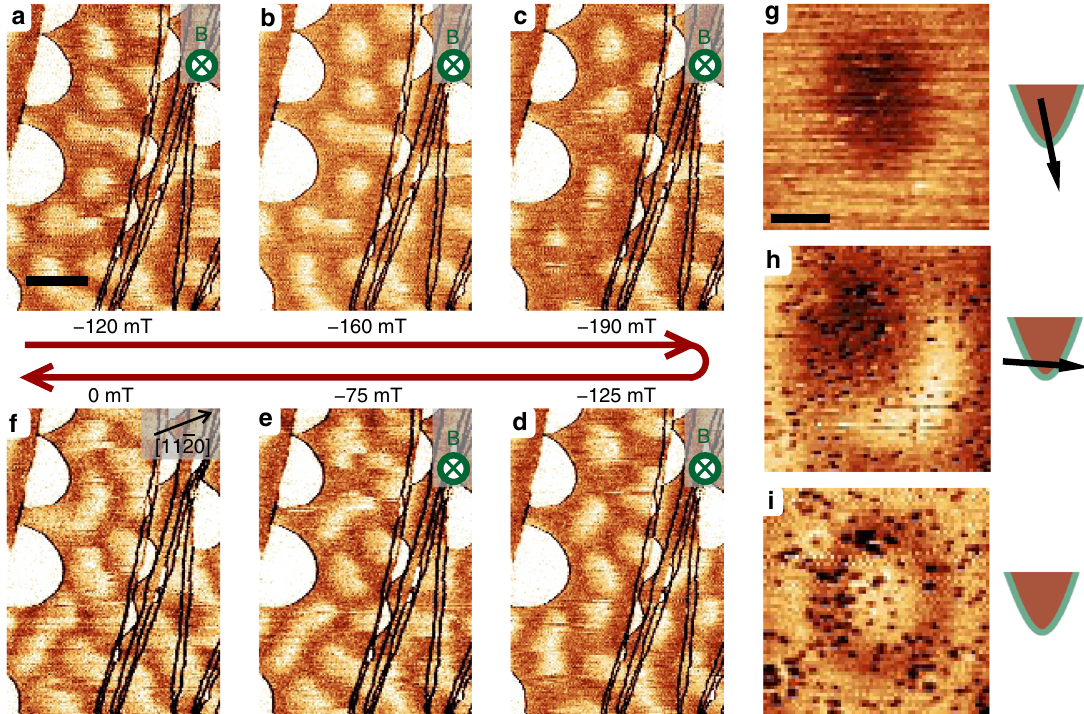
Fig. 3 Stabilization of magnetic skyrmions. a – f Spin-polarized d I /d U maps of the same area taken with out-of-plane magnetic fi elds as indicated ( I = 1 nA, U = − 400 mV, Δ U = 40 mV, scale bar is 50 nm). g – i Magni fi ed d I /d U maps recorded on the same skyrmion with an out-of-plane ( g ), in-plane ( h ), and rms non ( i ) spin-polarized tip ( I = 1 nA, U = − 400 mV for g and h and − 200 mV for i , Δ U rms = 40 mV for g and h and 30 mV for i , scale bar is 10